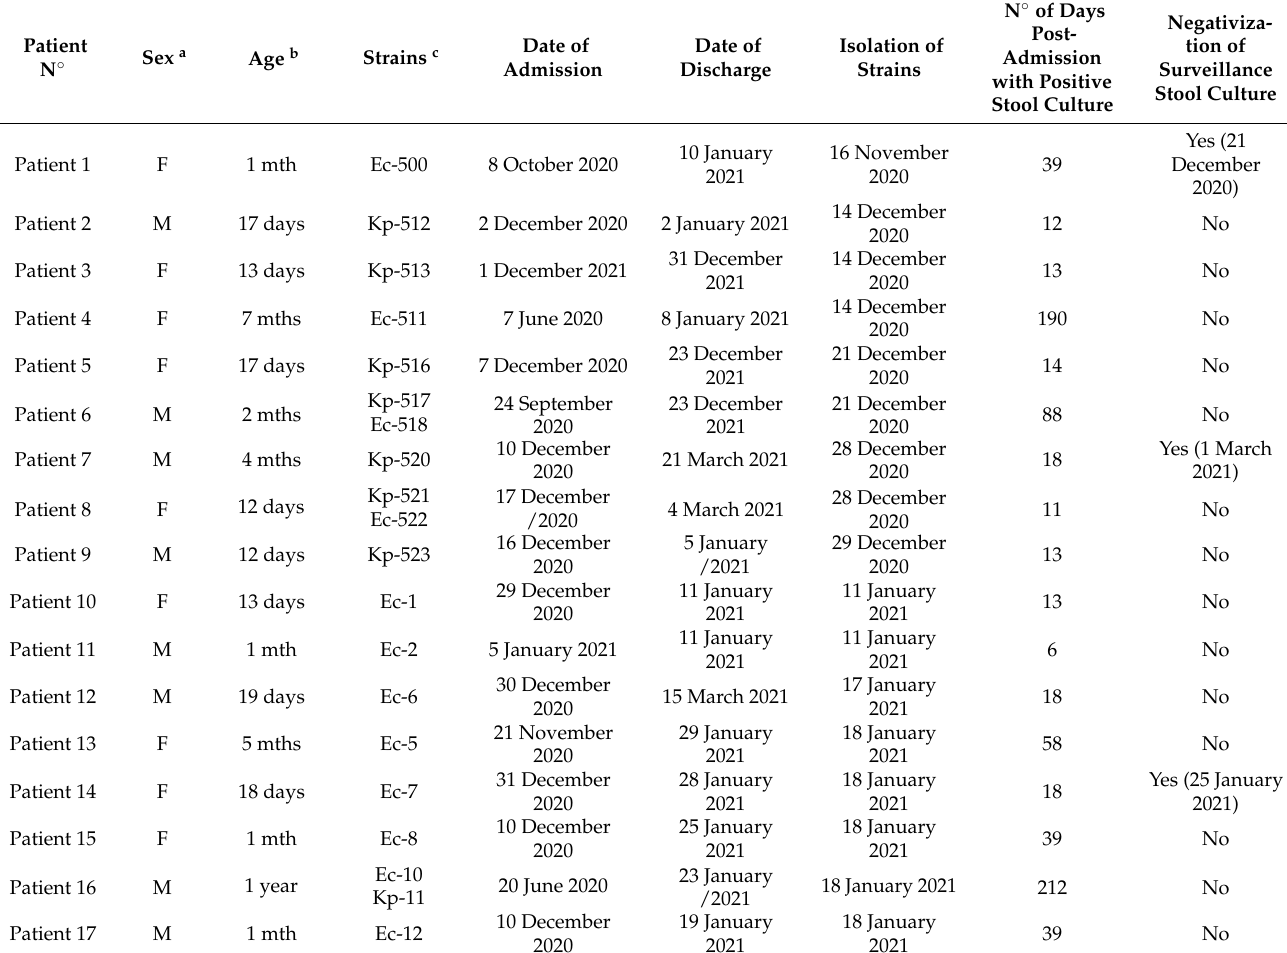
Table 1. Accessible clinical characteristics of patients who tested positive for intestinal colonization by NDM-1 producing K. pneumoniae and E. coli